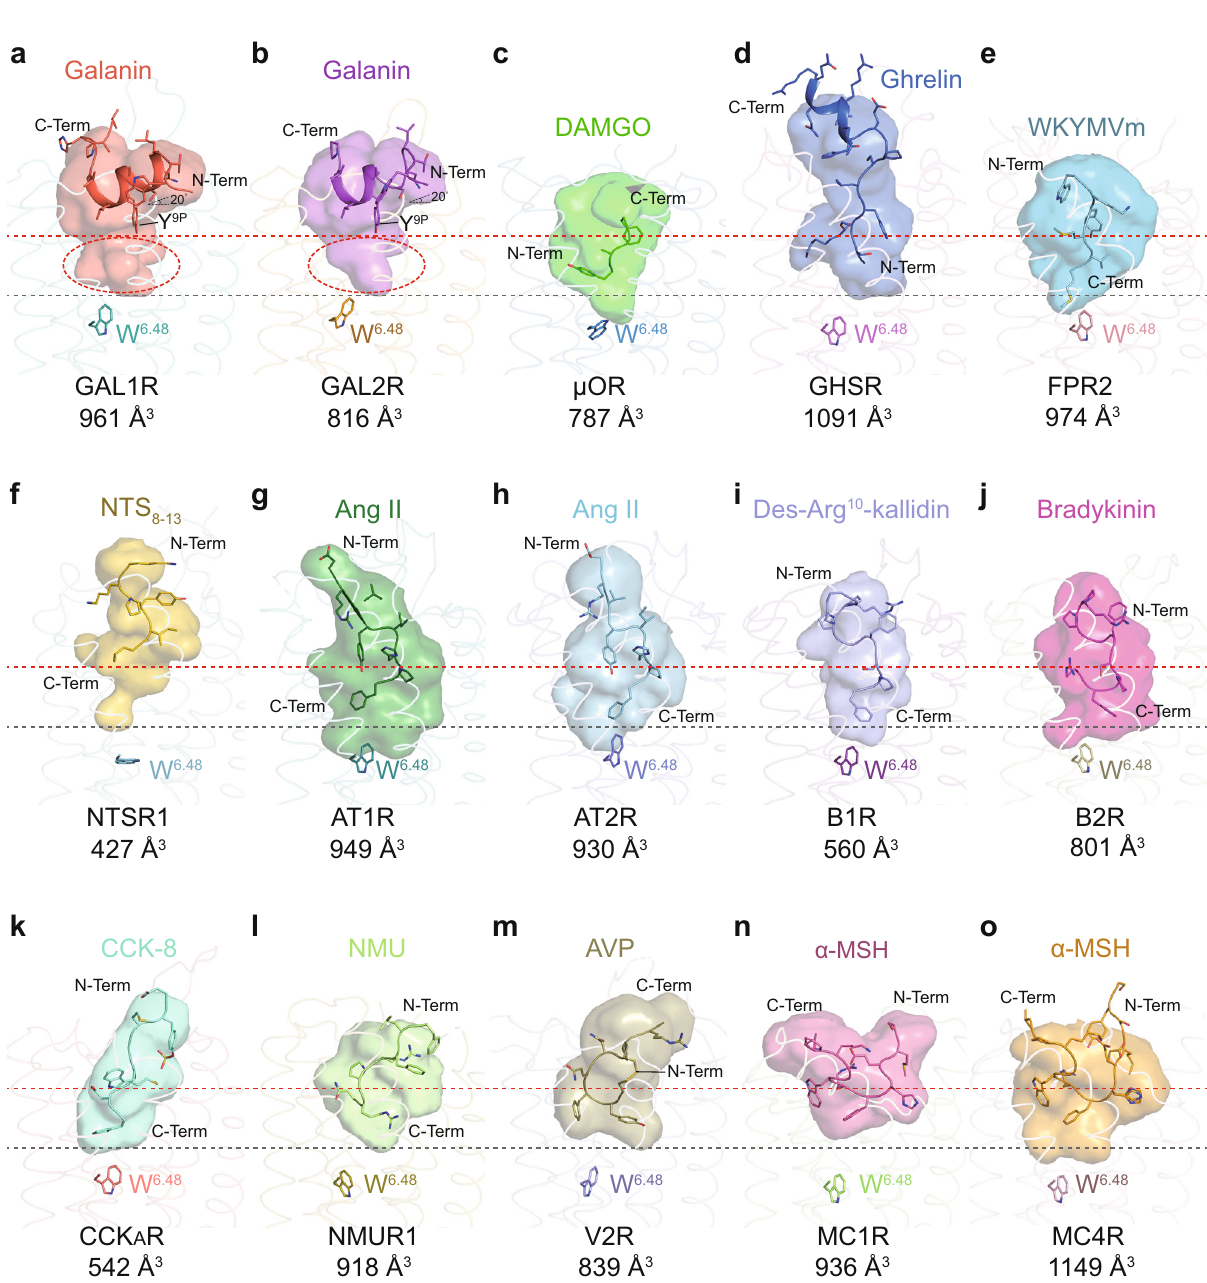
Fig. 2 Unique binding mode of galanin at GAL1R and GAL2R. a – o The binding modes of peptides at different peptide GPCRs. The peptides are shown in cartoon presentation and colored as indicated. The peptide-binding pockets are displayed as transparent surfaces with the same colors of speci fi c peptides. The volume of each orthosteric pocket was measured by POVME 2.0 49 . The N-terminus (N-Term), C-terminus (C-Term) of peptides and volumes of peptide-binding pockets are indicated. The depths of galanin-binding and the pocket in galanin receptors are highlighted as dashed reference lines in red and black, respectively. a Galanin in GAL1R; b galanin in GAL2R; Tilt angles (20°) compared to cell membrane and Y 9P of galanin are indicated. Extra binding pockets beneath galanin are highlighted as red dashed ovals. c DAMGO in mu-opioid receptor ( μ OR, PDB: 6DDE); d Ghrelin in ghrelin receptor (GHSR, PDB: 7F9Y); e WKYMVm in formyl peptide receptor 2 (FPR2, PDB: 6OMM); f Neurotensin 8-13 (NTS 8-13 ) in neurotensin receptor 1 (NTSR1, PDB: 6OS9); Angiotensin II (Ang II) in angiotensin II receptor type 1 (AT1R, PDB: 6OS0, g ) and type II (AT2R, PDB: 6JOD, h ); i Des-Arg10-kallidin in